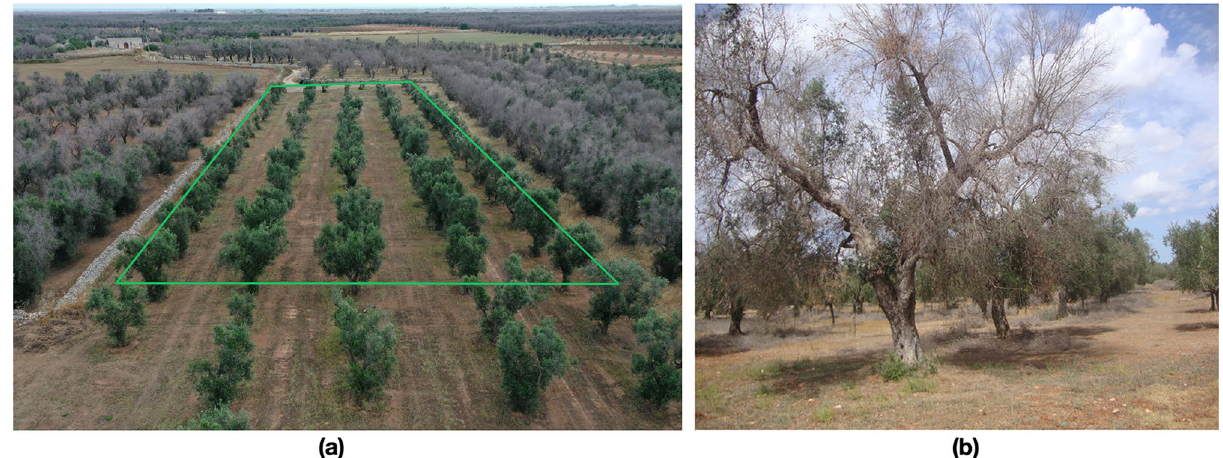
Figure 5. Cannole: ( a ) Image detected from drone in June 2022, after treatments. In green polygon, treated field surrounded by untreated fields; ( b ) tree with Xfp symptoms. Oliarola Salentina and Cellina di Nardò cultivars are planted both in treated and untreated